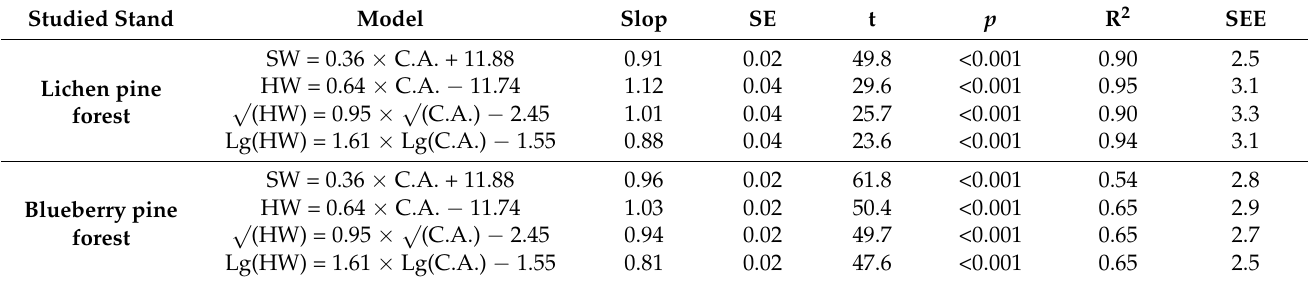
Table 5. Models developed for lingonberry pine forest [45] describe the dependence of the number of heartwood rings as a function of cambium age for Scots pine and general statistics for lichen and blueberry pine forests.